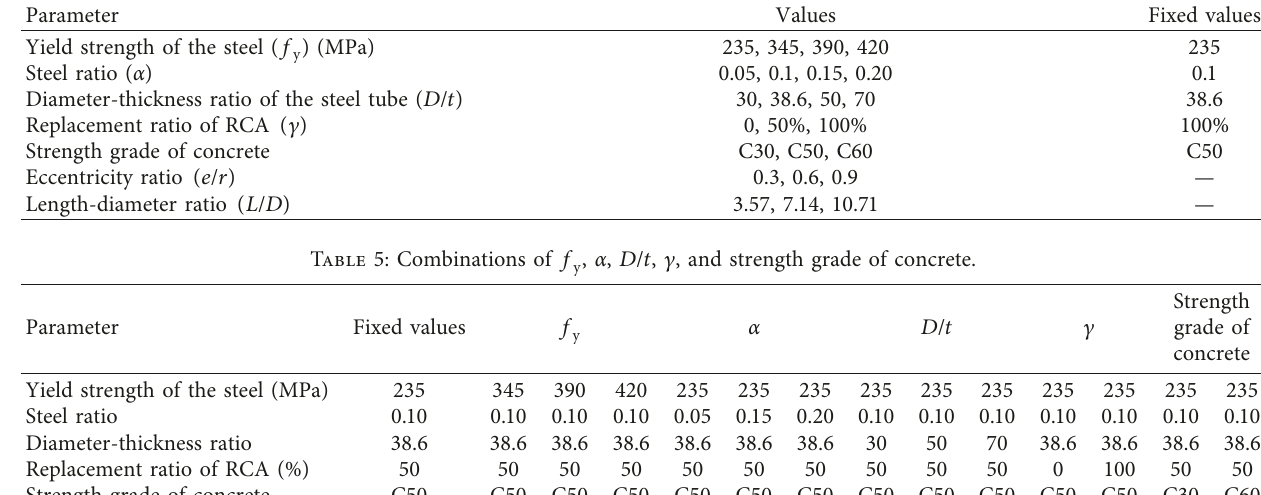
— — — Table 4: Values of studied parameters.